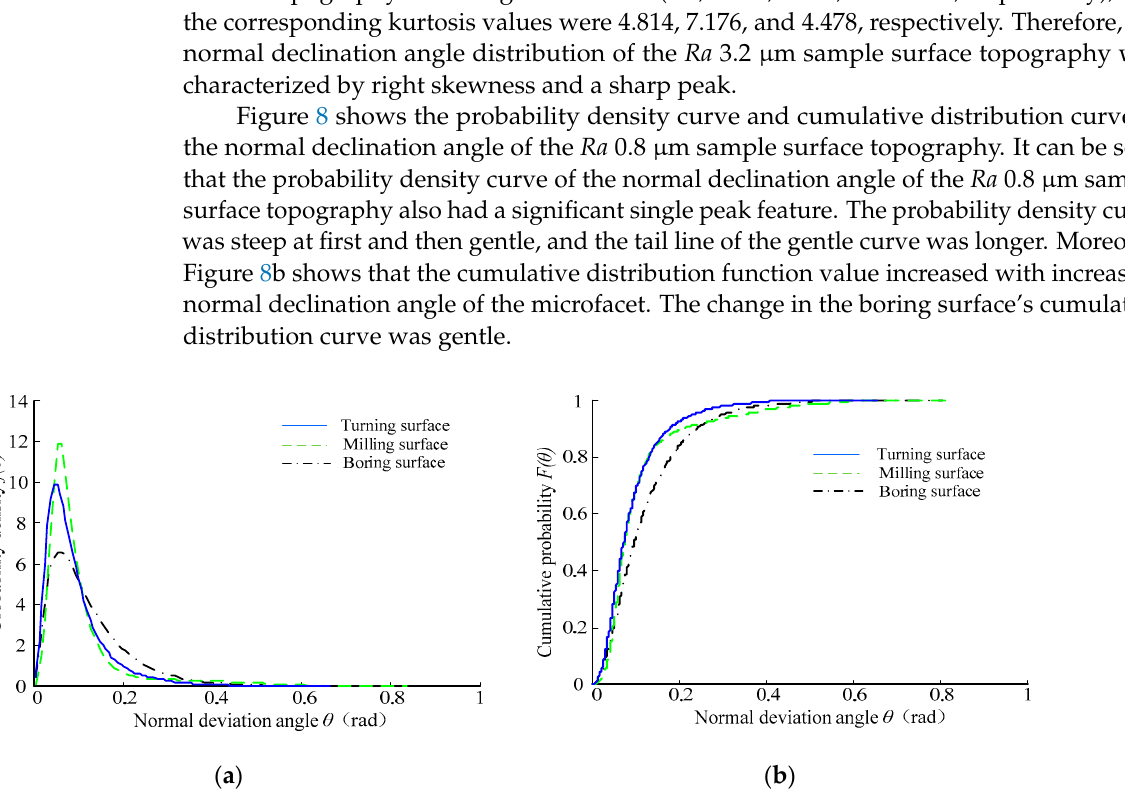
Figure 8. The distribution curves of the normal declination angle of Ra 3.2 μ m machined surface topography. ( a ) Probability density curve; ( b ) cumulative distribution curve.